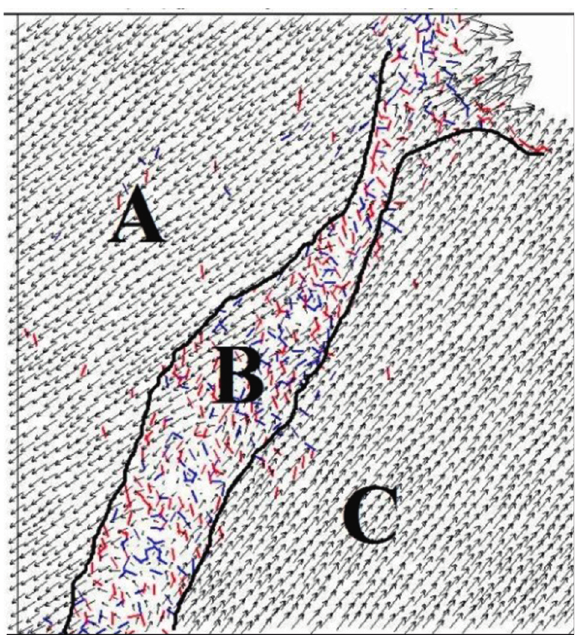
Figure 11: Microstructure of the fault zones after loading.